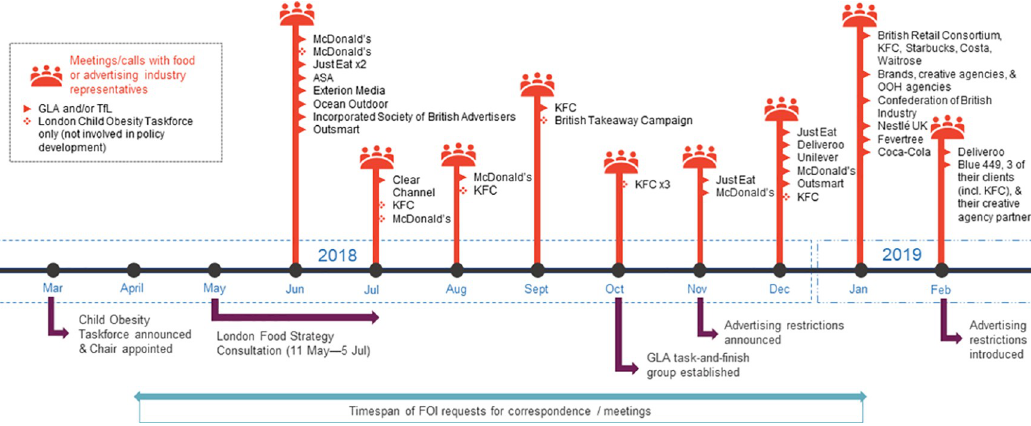
Fig 3. Timeline of the year leading up to the introduction of the TfL advertising restrictions and engagements with food and advertising industry actors during this time. Details can be found in S3 Table.